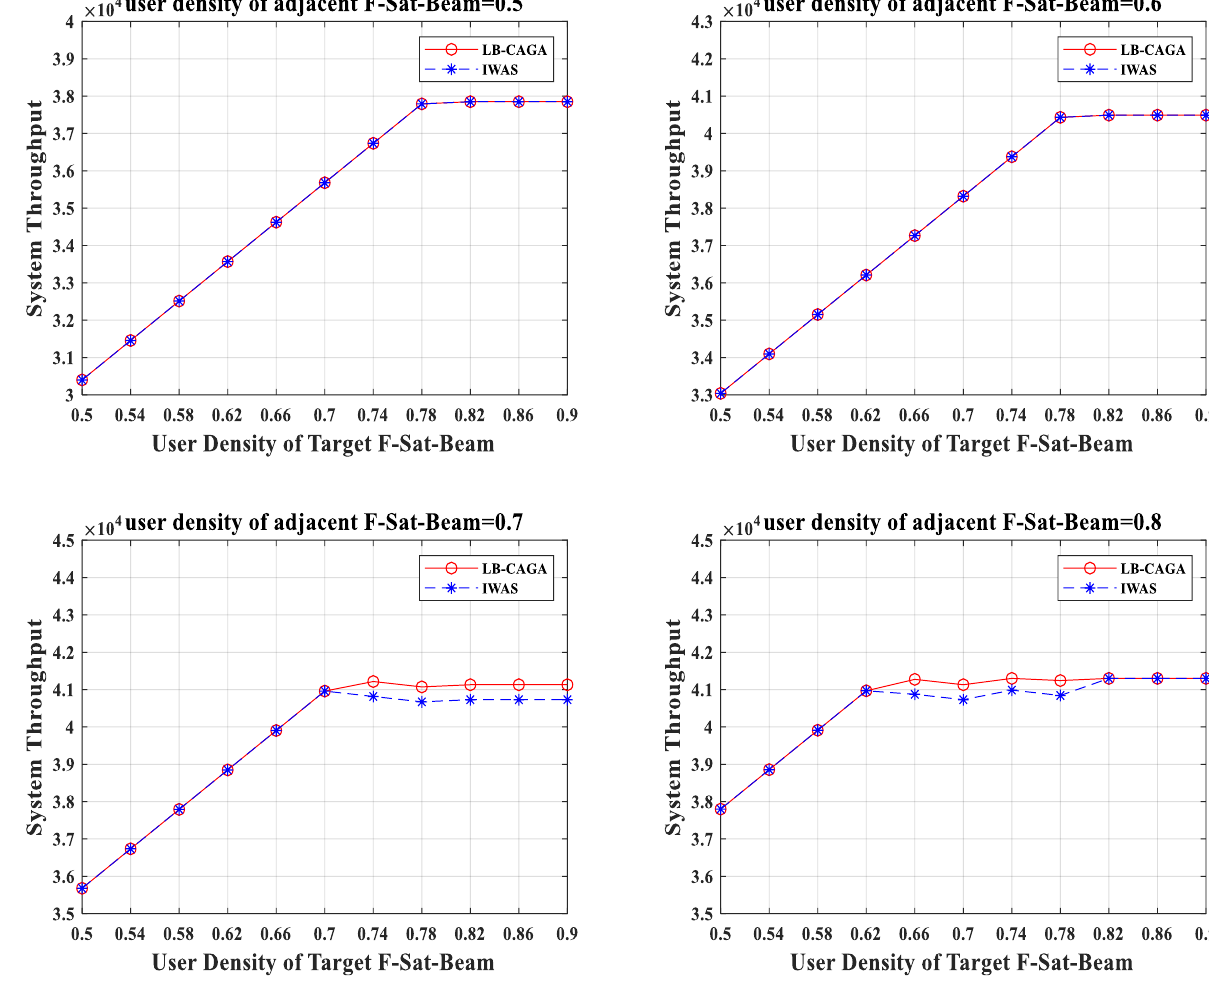
Figure 9. The performance of improved load balancing schemes.